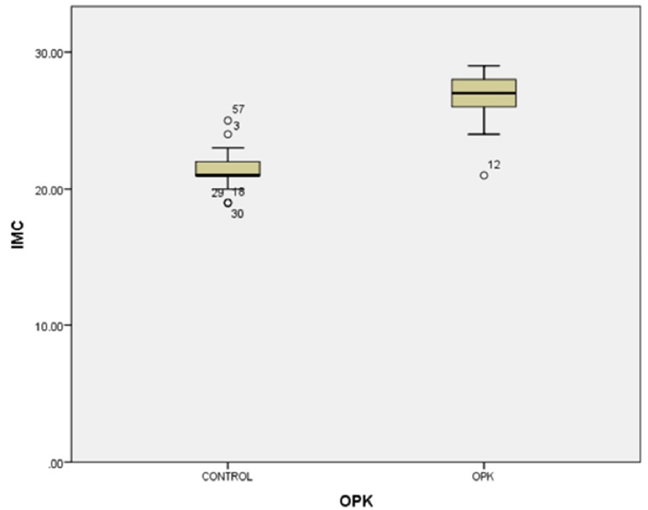
Figure 3. Univariate analysis between body mass index and PCOS ( p < 0.01). Circles represent high potential outliers and the stars represent high extreme values.